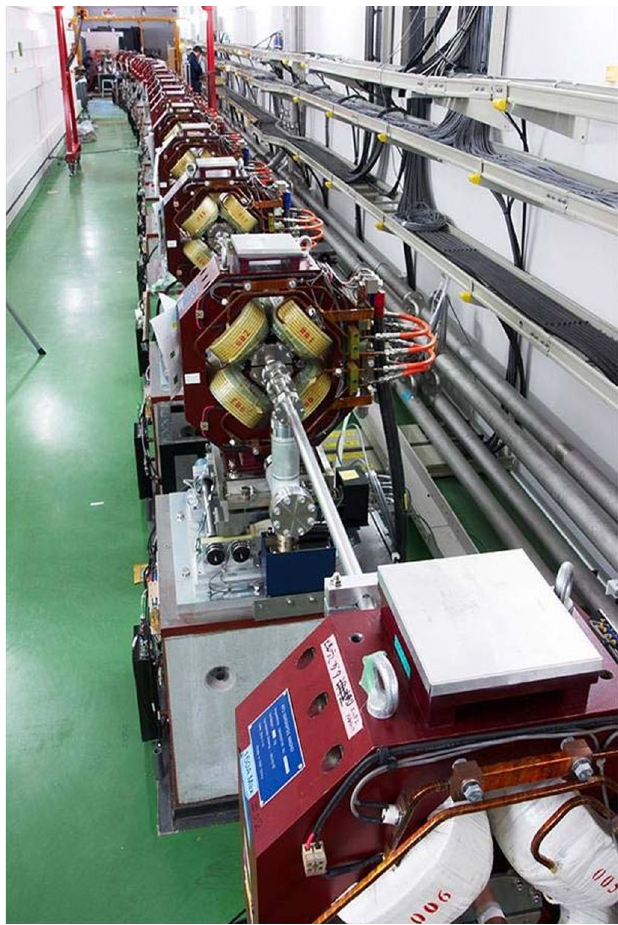
FIG. 3. (Color) View looking downstream along the final focus section of the ATF2 beam